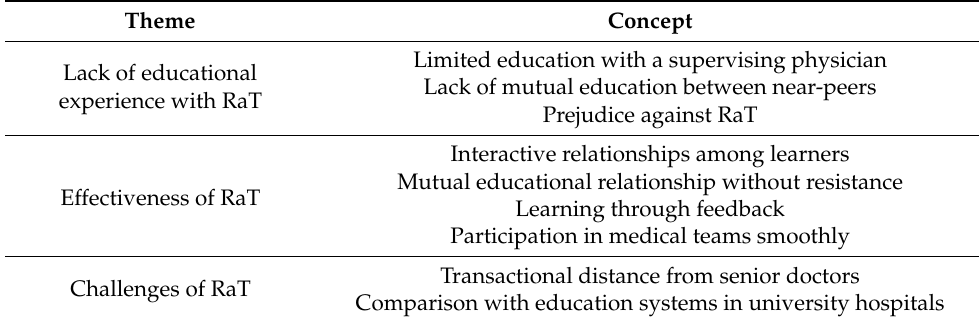
Table 1. The results of the thematic